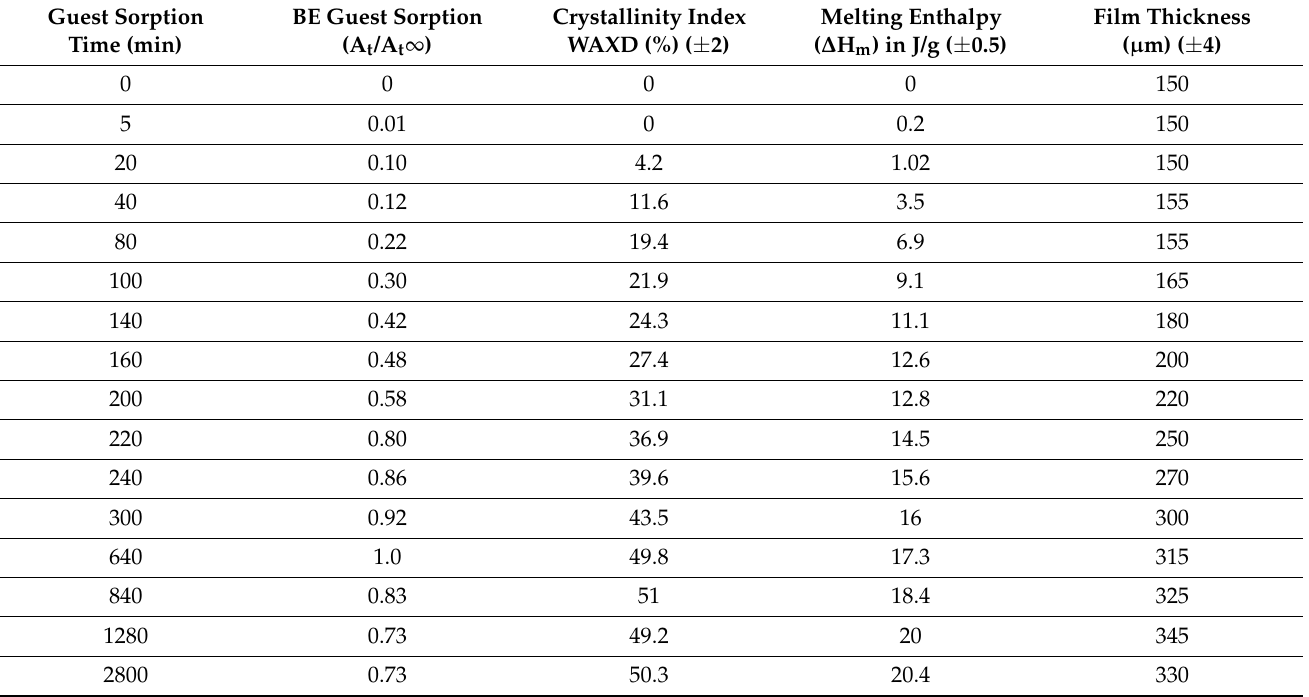
Table 2. BE guest sorption at room temperature in amorphous PPO films, with thickness of ~150 µ m, followed by guest removal leading to NC α form: sorption time (min); BE guest uptake (A t /A t ∞ ); WAXD crystallinity index (%); melting enthalpy (J/g); film thickness ( µ